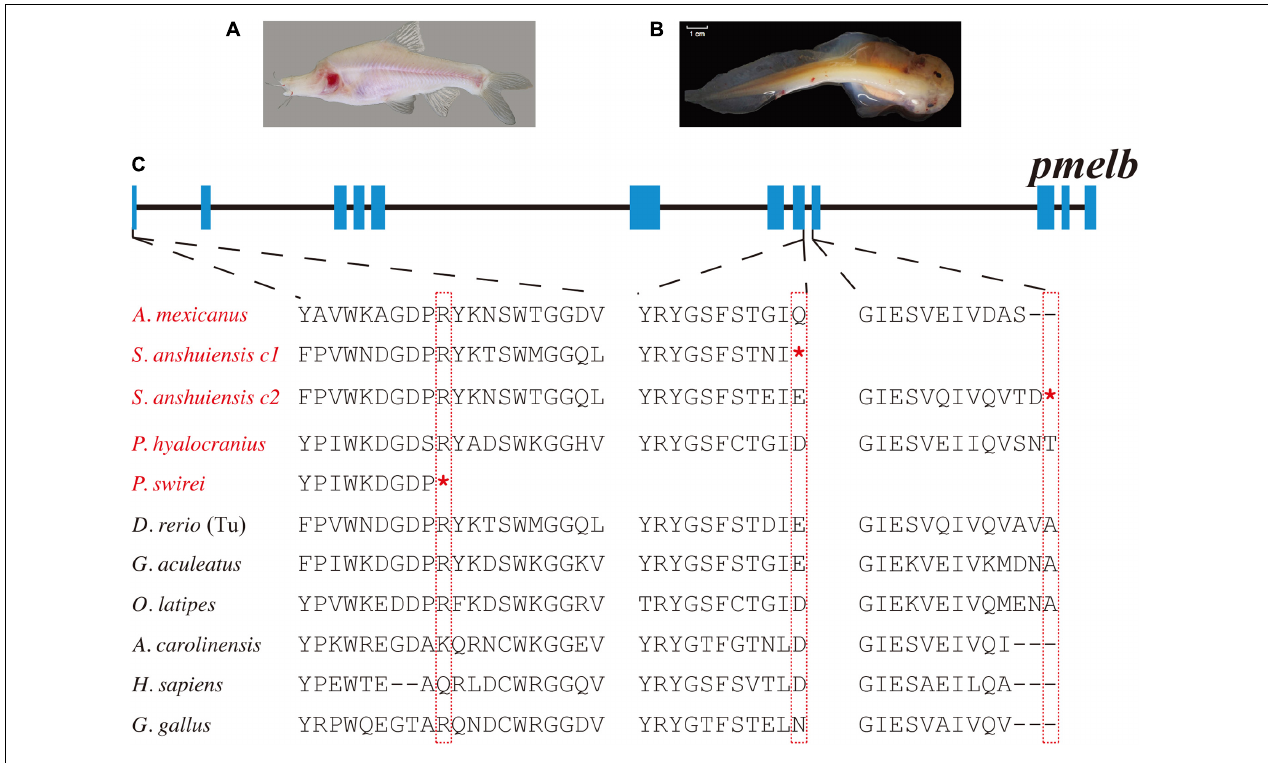
FIGURE 3 | Multiple sequence alignments of pmelb in ten representative species. (A,B) Photos of a cave-restricted golden-line barbel fish ( S. anshuiensis ) and a deep-sea snailfish ( P. swirei ). This deep-sea snailfish figure was adopted from Wang et al. (2019) with permission. (C) Nonsense mutations in the pmelb exons of S. anshuiensis and P. swirei. Species with melanin loss were marked in red. c1 and c2 represent copy 1 and copy 2. *Represents the premature stop